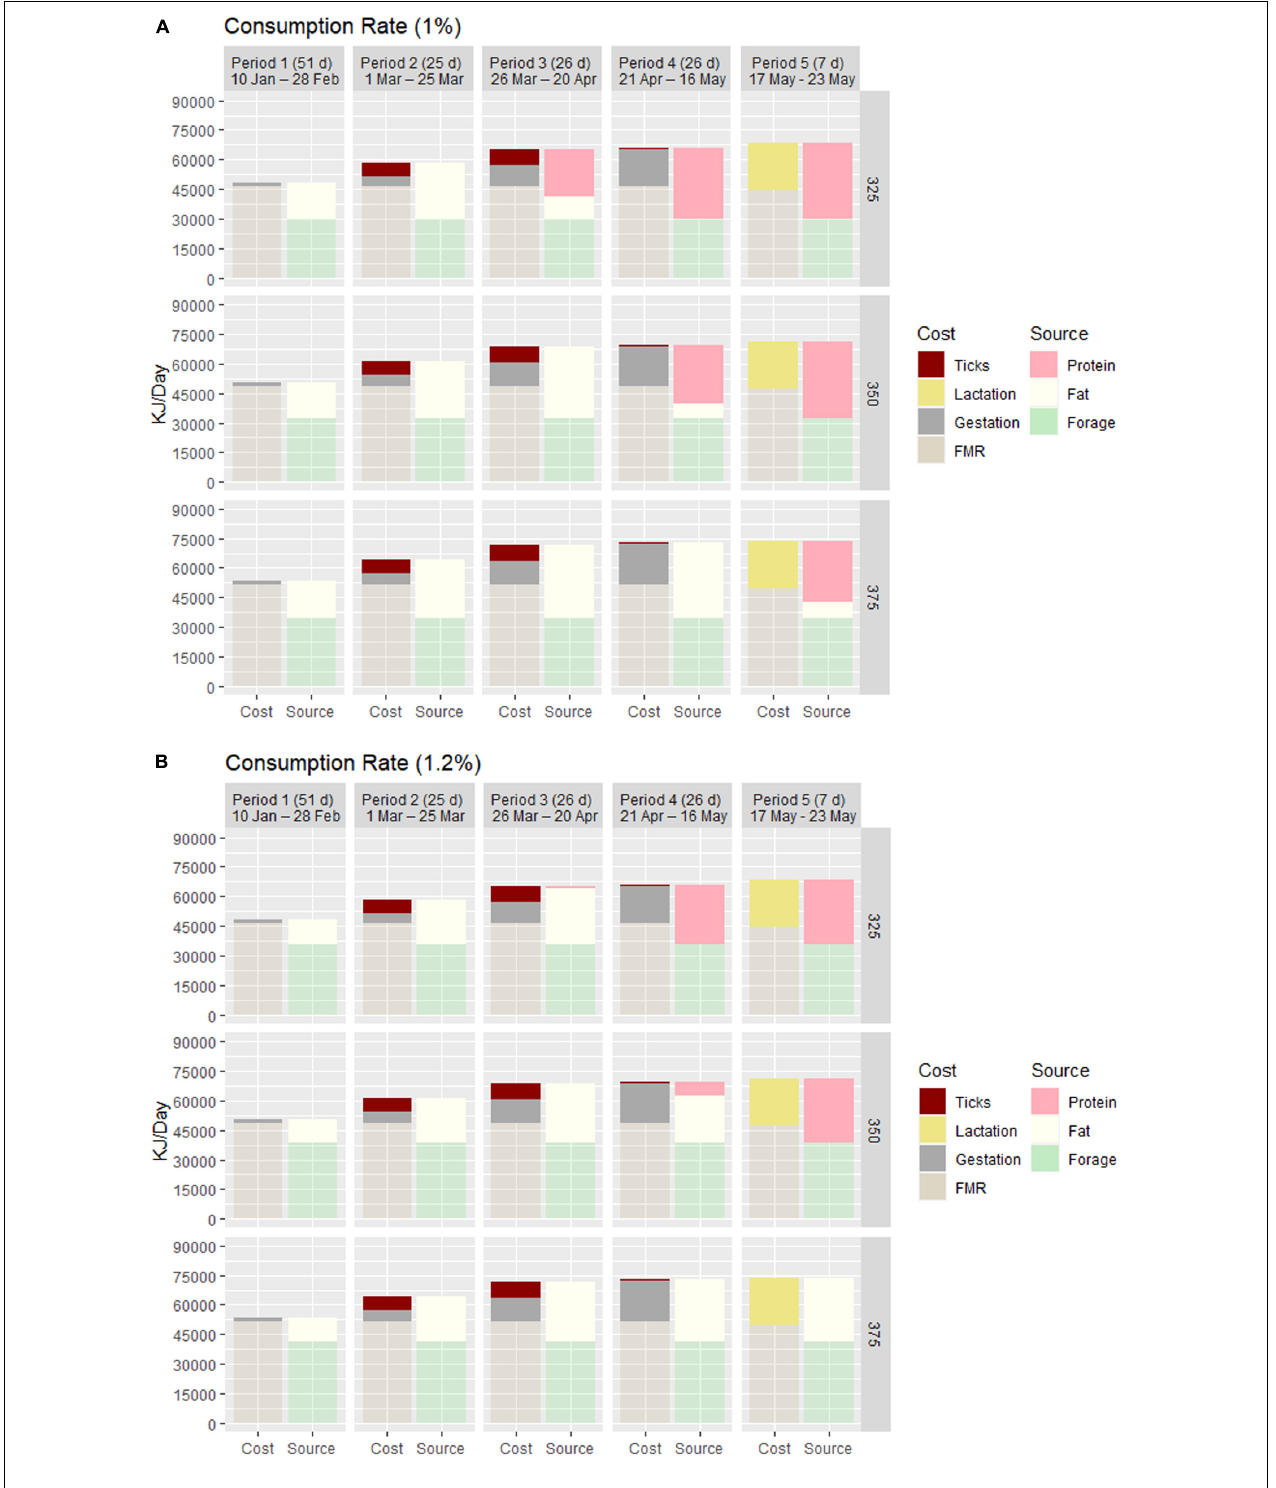
FIGURE 2 | The proportional cost and source of the daily energy budget of adult cow moose of different starting body mass (325, 350, and 375 kg) and body fat (15, 20, and 25%) in five distinct periods from 10 January through 16 May. Period 1 was the latter part of the 2nd trimester of gestation (50 days), Periods 2–4 represented distinct periods (25, 26, and 26 days) of exponentially increasing cost of gestation with Periods 2 and 3 accounting for the concentrated blood loss to winter ticks, and Period 5 was lactation (7 days). The bars indicate how cost (field metabolic rate, gestation, blood loss, and lactation) was met relative to source (forage, BF, and BP) and the time frame at which a BF deficit occurs and BP is used. Consumption was varied as 1% (A) and 1.2% body mass (B) to illustrate its relative impact on energy balance.